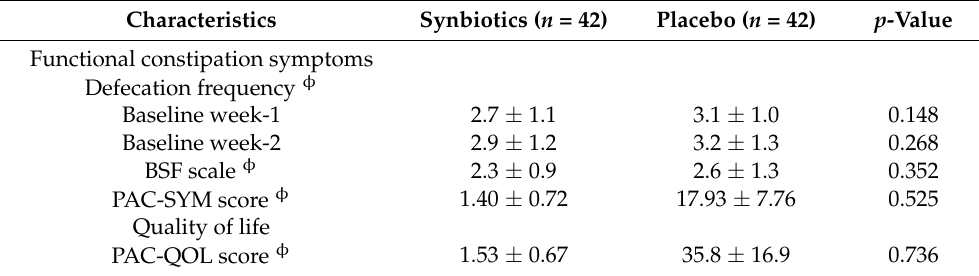
Table 2. Participants’ functional constipation symptoms and quality of life at